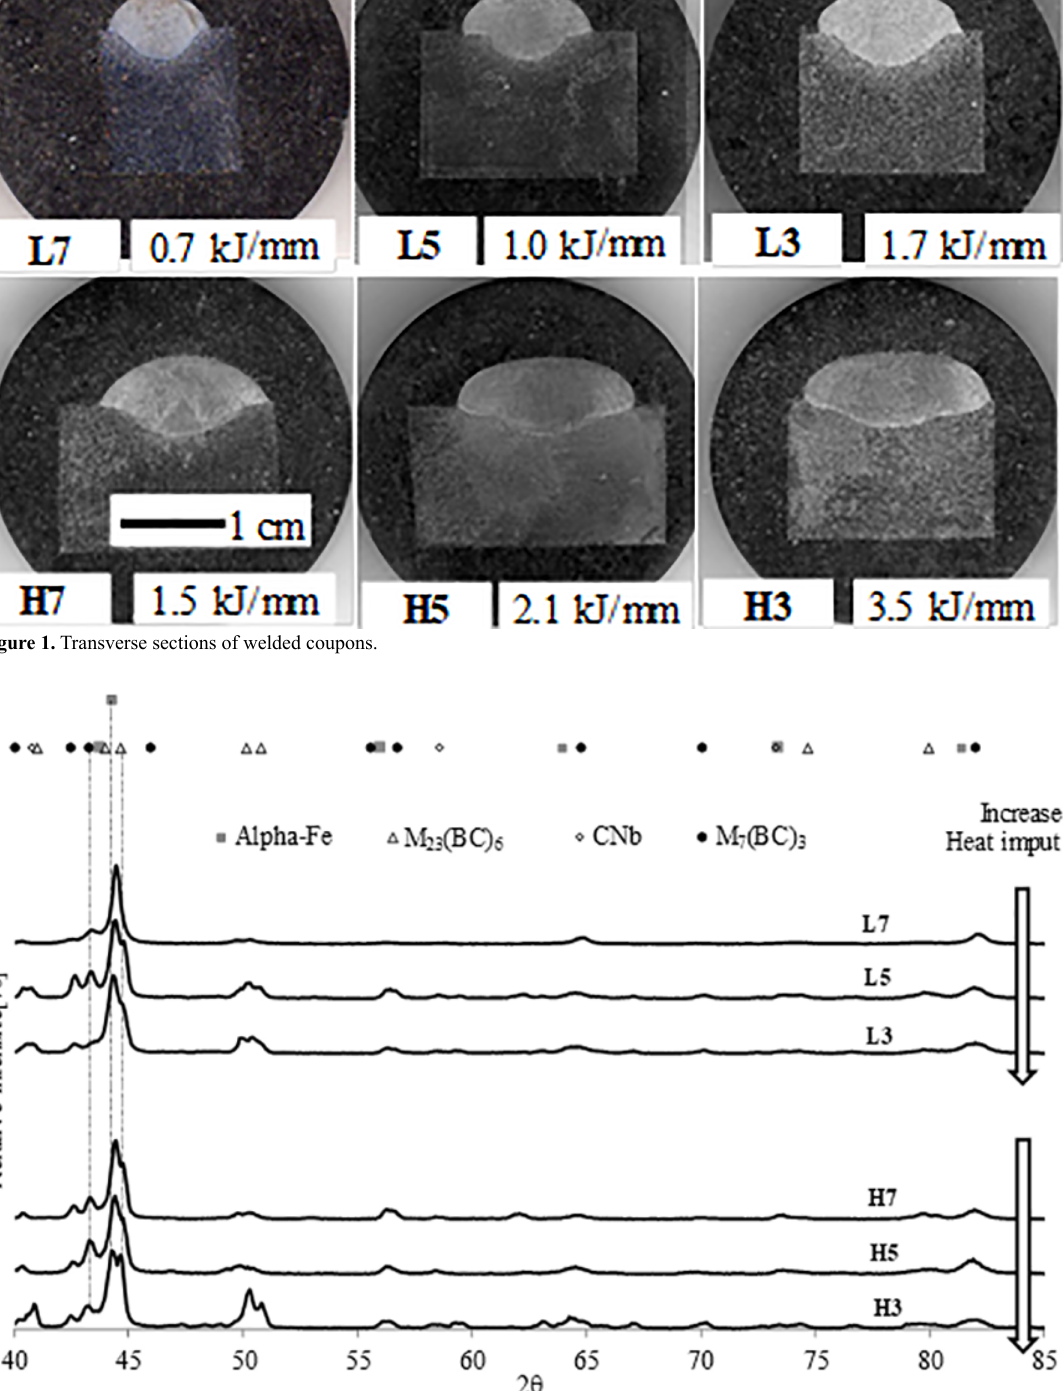
Figure 2. X-ray diffraction